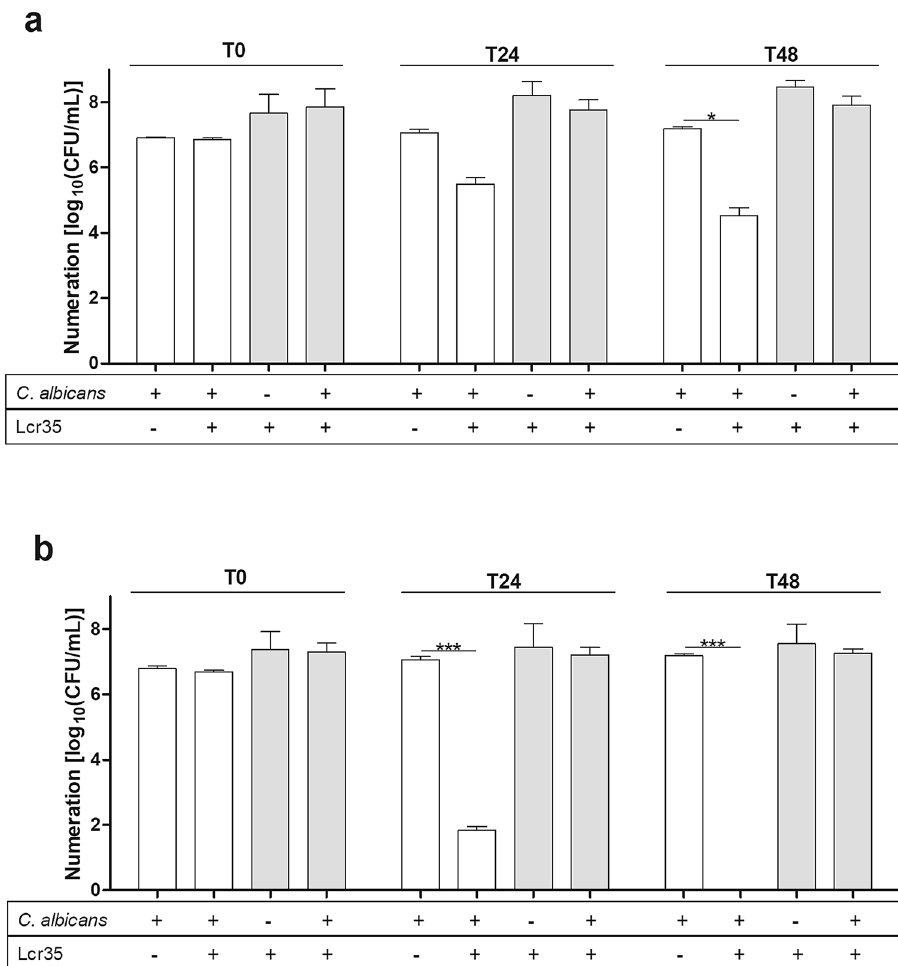
Figure 1. Effect of Lcr35 on the viability of Candida albicans ATCC 10231 in the absence ( a ) and in the presence ( b ) of STS (1 g/l). Viability of C. albicans white bar and Lcr35 grey bar determined at strain contacting (T0), after 24 h (T24) and 48 h (T48) of co-incubation with Lcr35 ( a ), and with STS (1 g/l) ( b ). Controls were incubated in same conditions. N = 3, *p < 0.05, **p < 0.01, ***p < 0.001 (one-way ANOVA test and Bonferroni